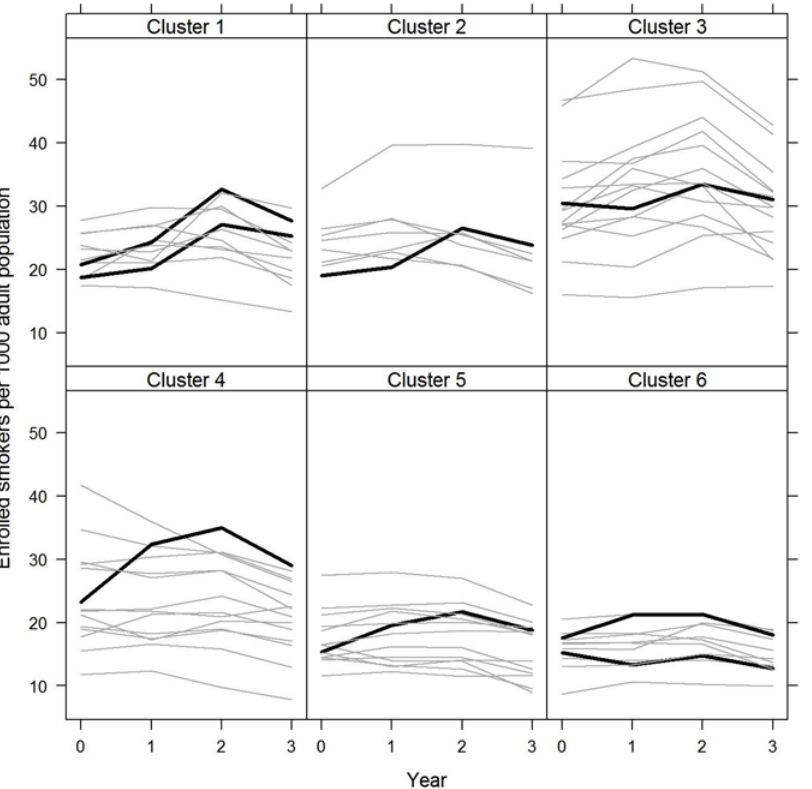
Fig 1. 4-week quits per 1,000 adult population for intervention and control PCTs by cluster: 2009/10 to 2012/13 The figure shows the change in quits over time for the intervention PCTs compared to their comparators in each of the six clusters. The clusters use the Office for National Statistics (ONS) subgroup categories for geographic areas of the UK based on similar local population characteristics. The eight intervention PCTs fall into six ONS subgroups along with 64 other PCTs which form the controls. Intervention PCTs are shown in black and control PCTs are shown in grey. 2009/10 = 0 and 2012/13 = 3.